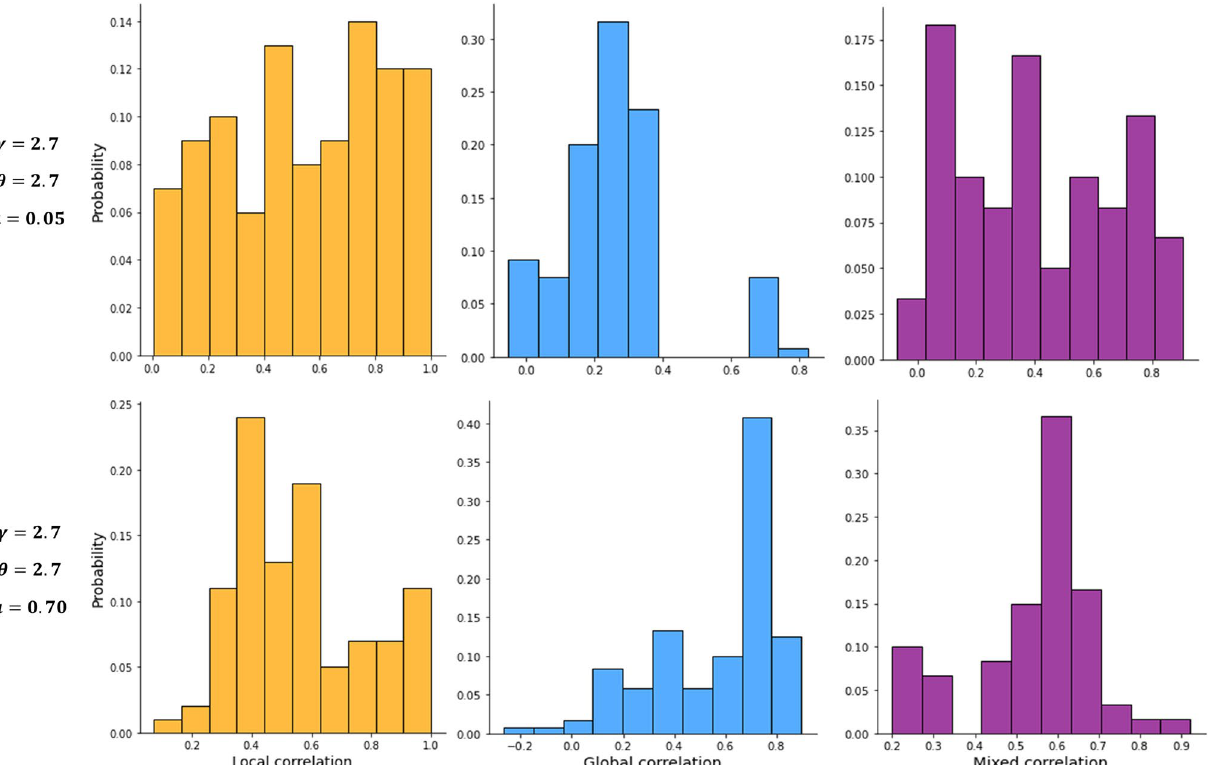
Figure 2. Histograms of the correlation between classical and local, global, and mixed community-aware centrality measures. The top histograms are for a strong community structure ( µ = 0.05). The bottom histograms are for a weak community structure ( µ =